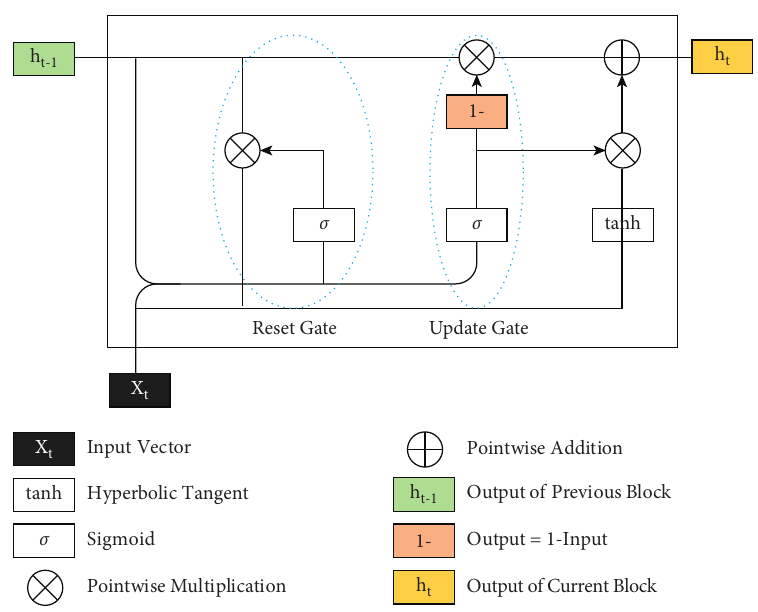
Figure 6: The structure of gated recurrent unit (GRU) network